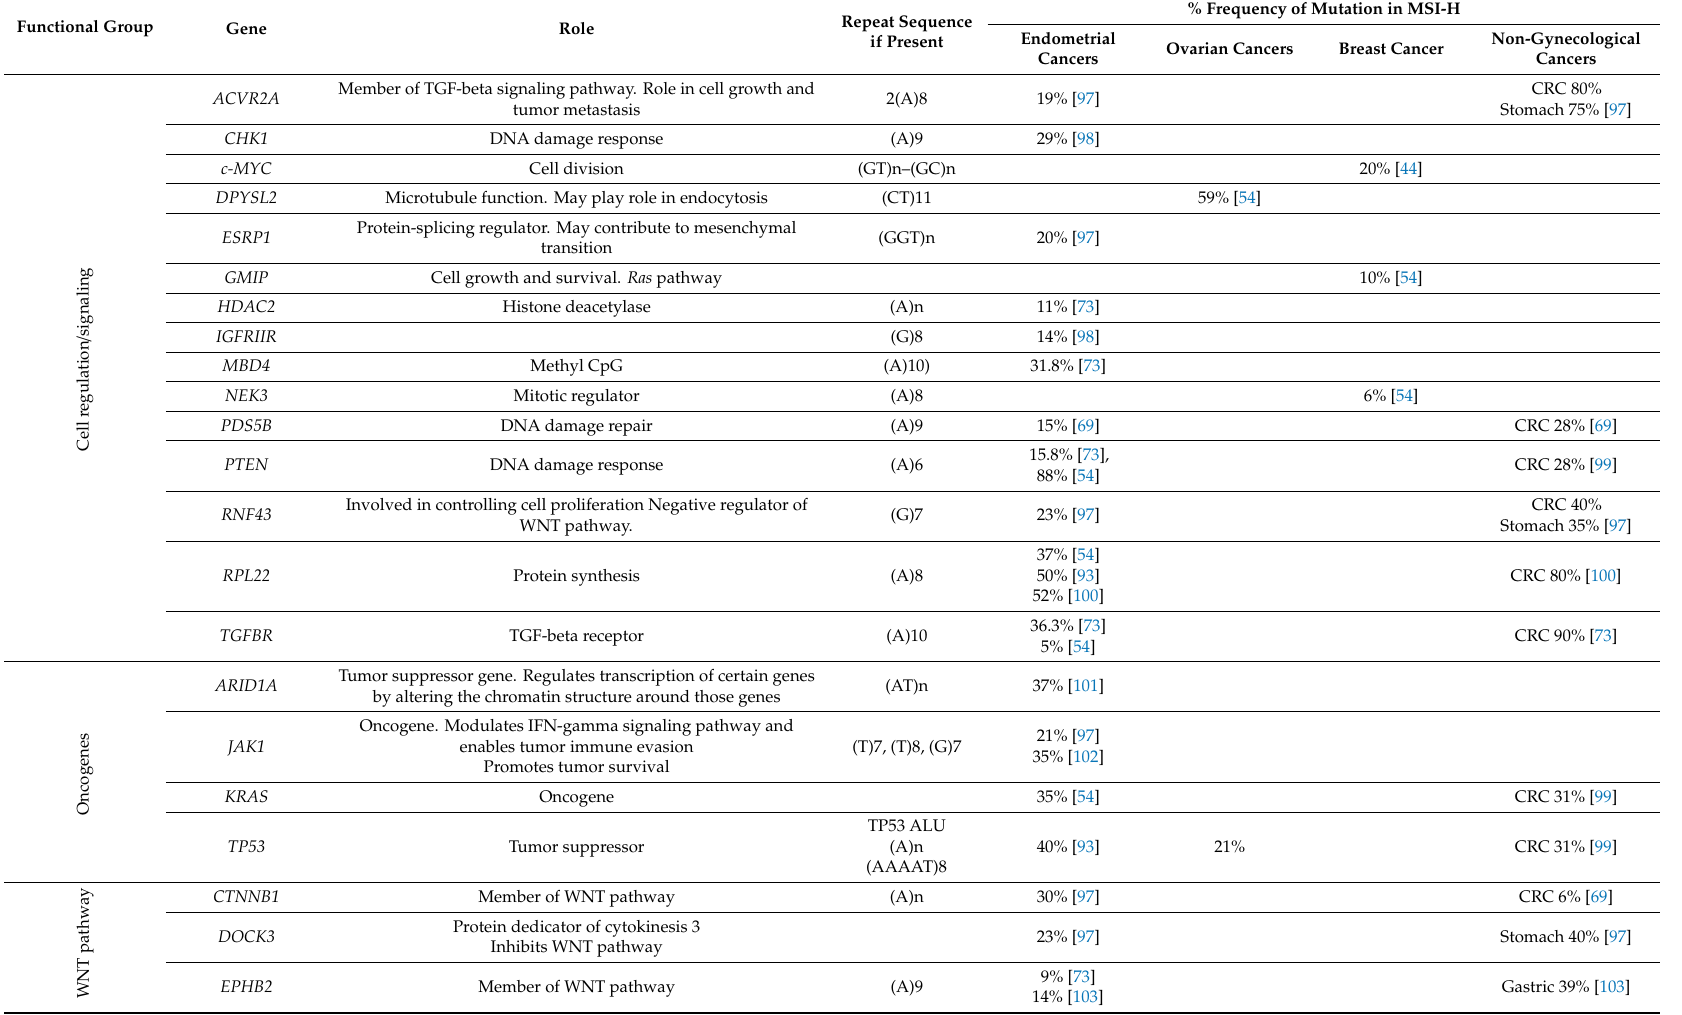
Table 2. Target genes that harbor MSI in gynecological